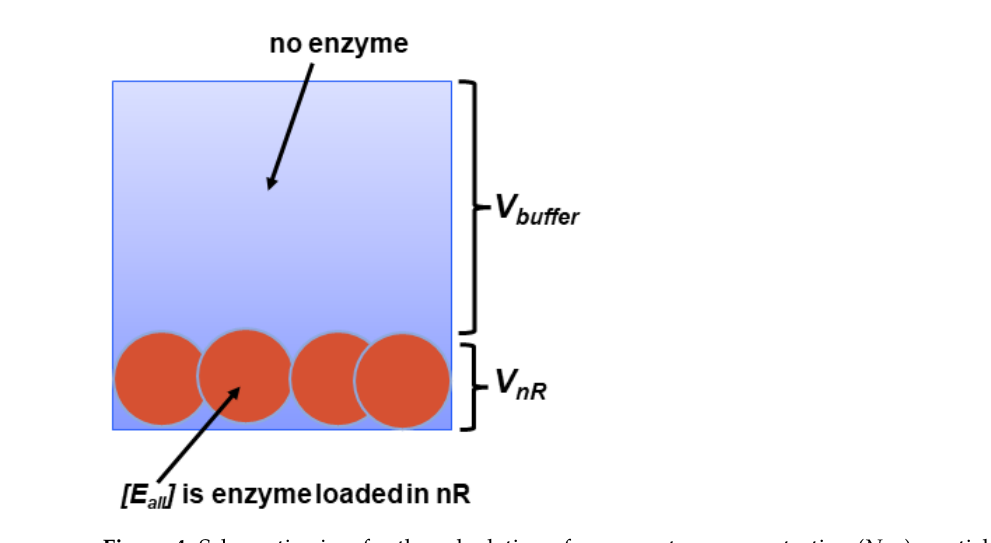
Figure 4. Schematic view for the calculation of nanoreactors concentration ( N nR ), particle number concentrations/mL of the preparation, where V all is the total volume and V nR is the volume occupied by the nanoreactors.